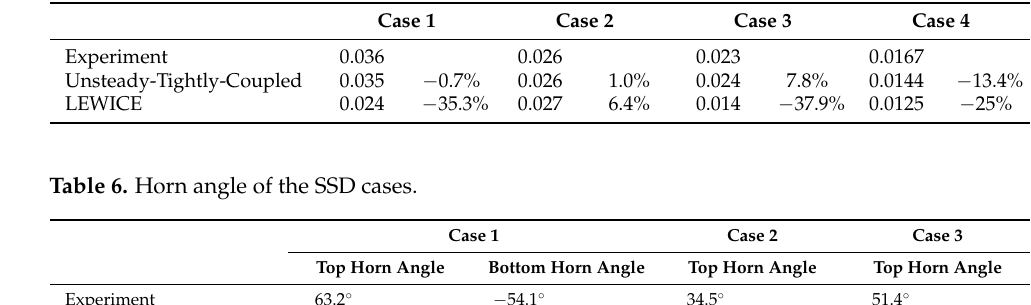
Table 5. Stagnation thickness of the SSD cases.